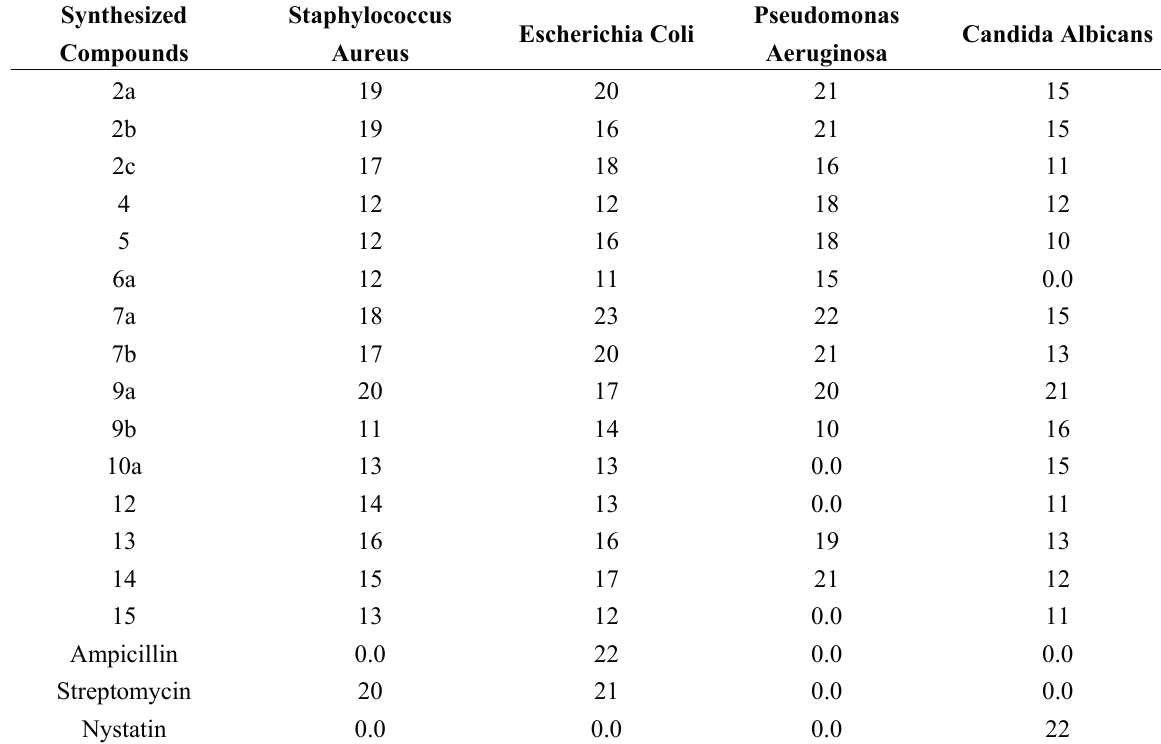
Table 1. Antimicrobial activity of compounds 2 – 15